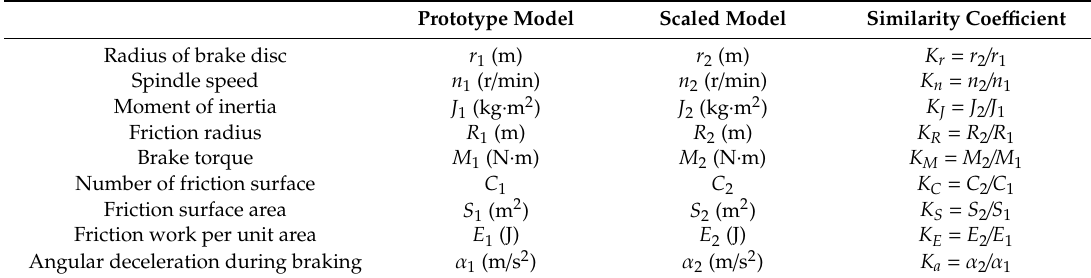
Table 2. Main physical parameters in the prototype and scaled models during emergency